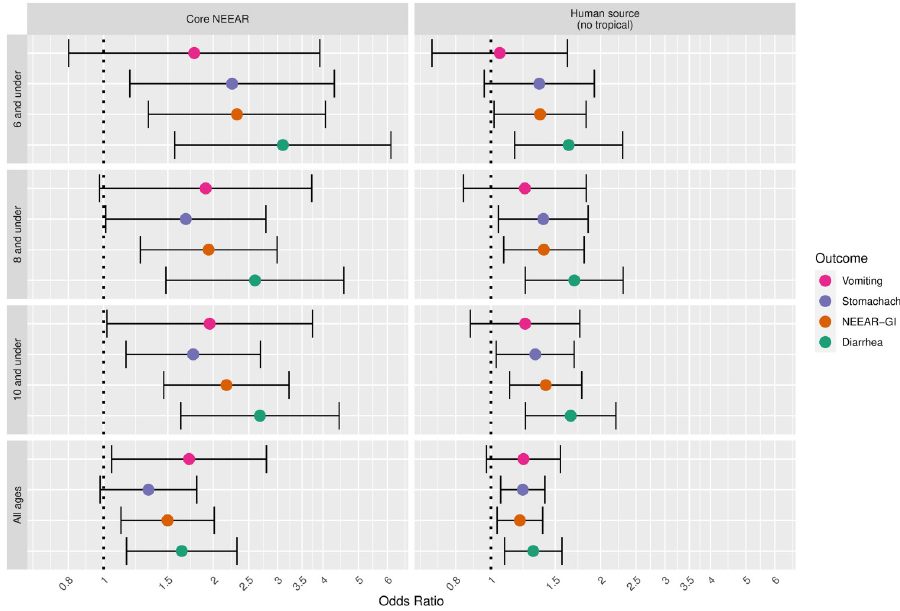
Fig 11. Odds ratios for gastrointestinal outcomes associated with a 1-log10 increase in Enterococcus qPCR CE among those spending 60 minutes or more in the water.